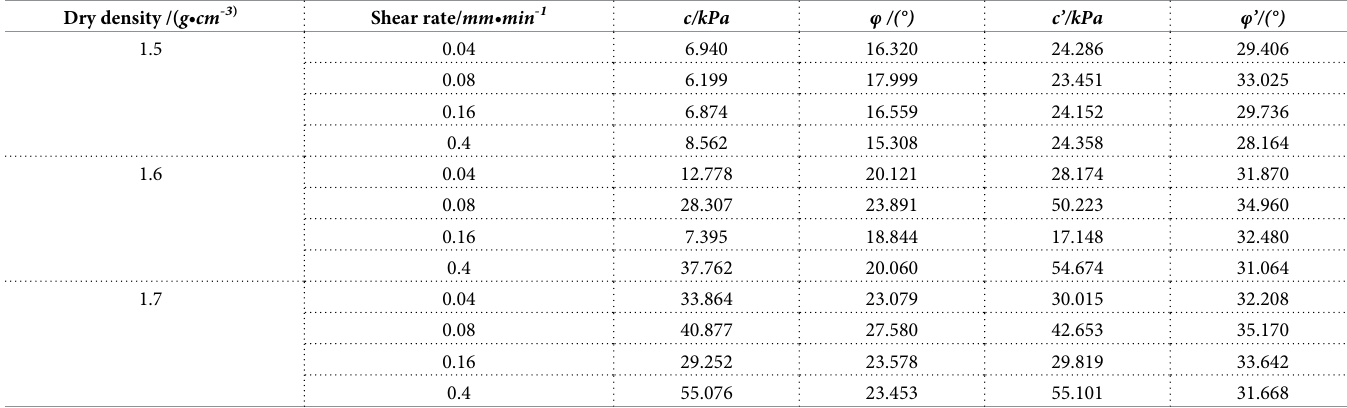
Table 4. Effective residual shear strength and total residual strength under different dry density and shear rate conditions. Dry density /( g•cm -3